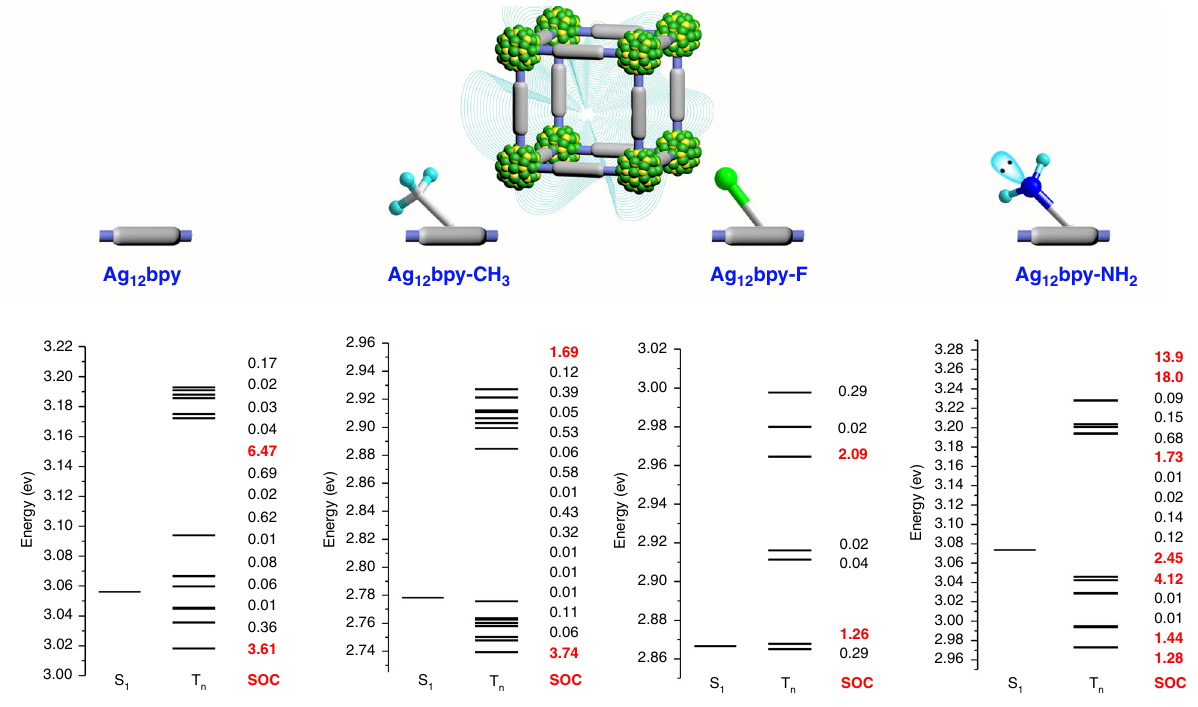
Fig. 5 Energy level diagram and SOC constants. The SOC values are in cm − 1 , and the high values (>1 cm − 1 ) are in bold red. There are 4, 8, 1, and 10 triplet states that are lower than the corresponding singlet state of the pristine, − CH 3 , − F, and − NH 2 substituted molecules. Considering that the resonance structures may promote ISC 47 , the higher triplet states with a low energy gap ( Δ E S1Tn < 0.15 eV) were